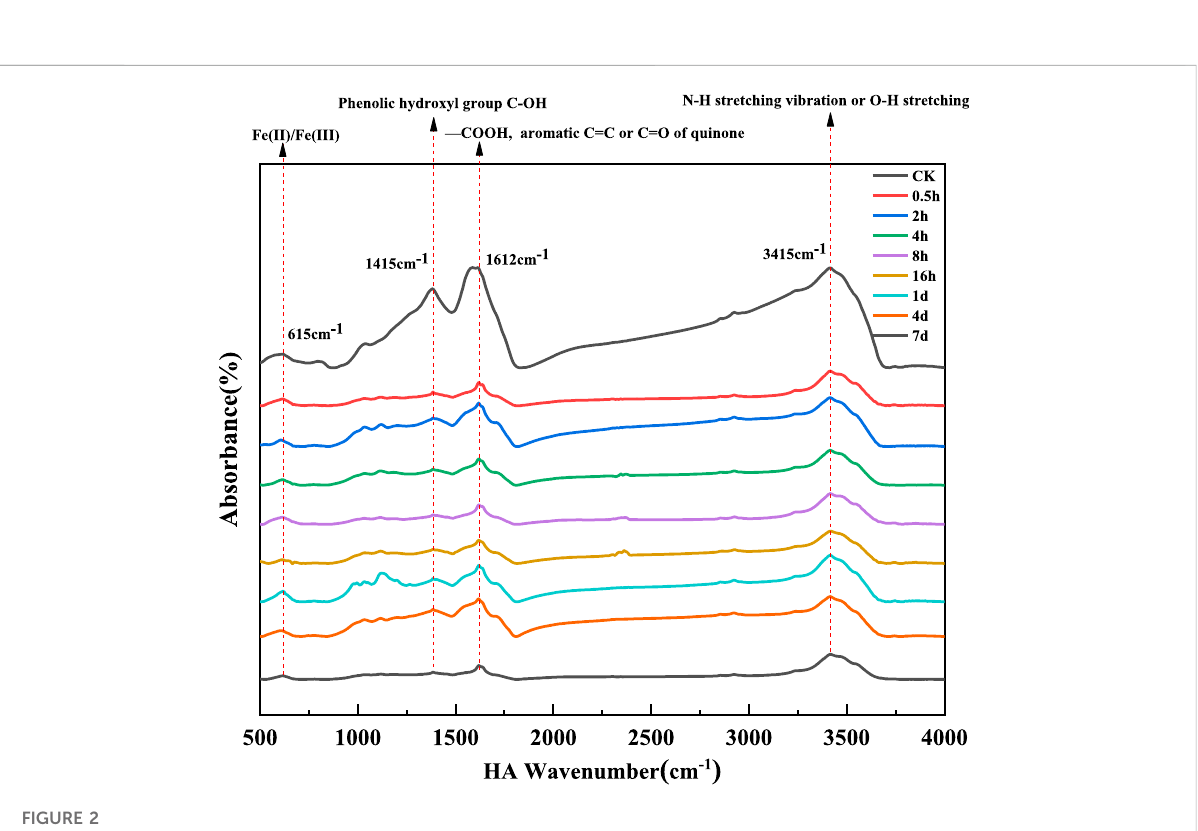
FIGURE 2 FTIR spectrum of HA samples at different reaction